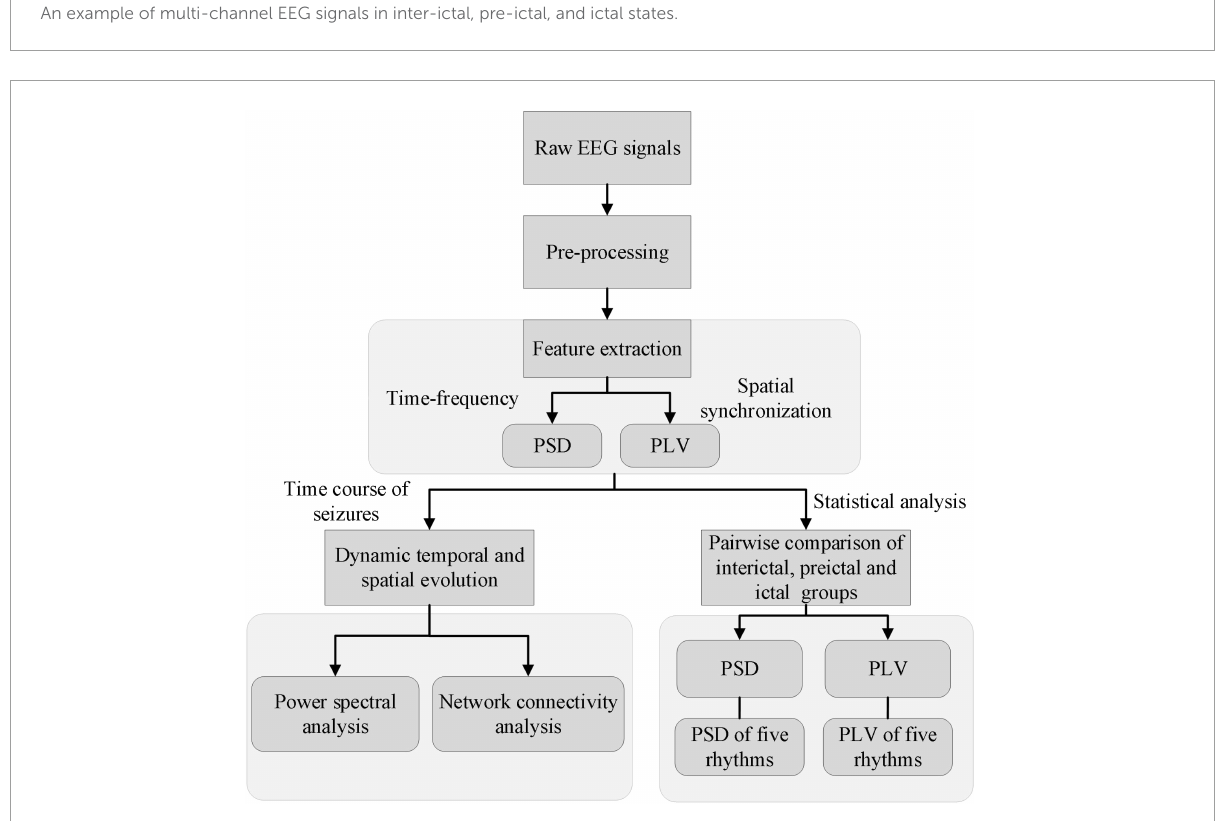
FIGURE2 A schematic illustration shows the detailed steps of the study.